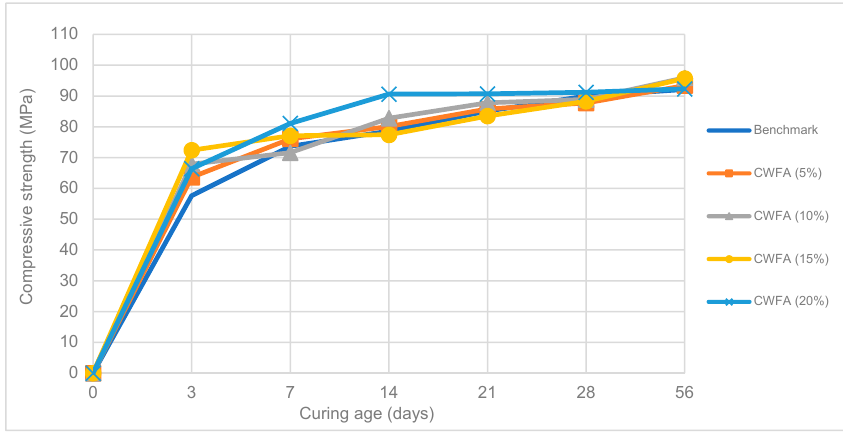
Figure 7. Compressive strength variation of samples containing various doses of CWCA.